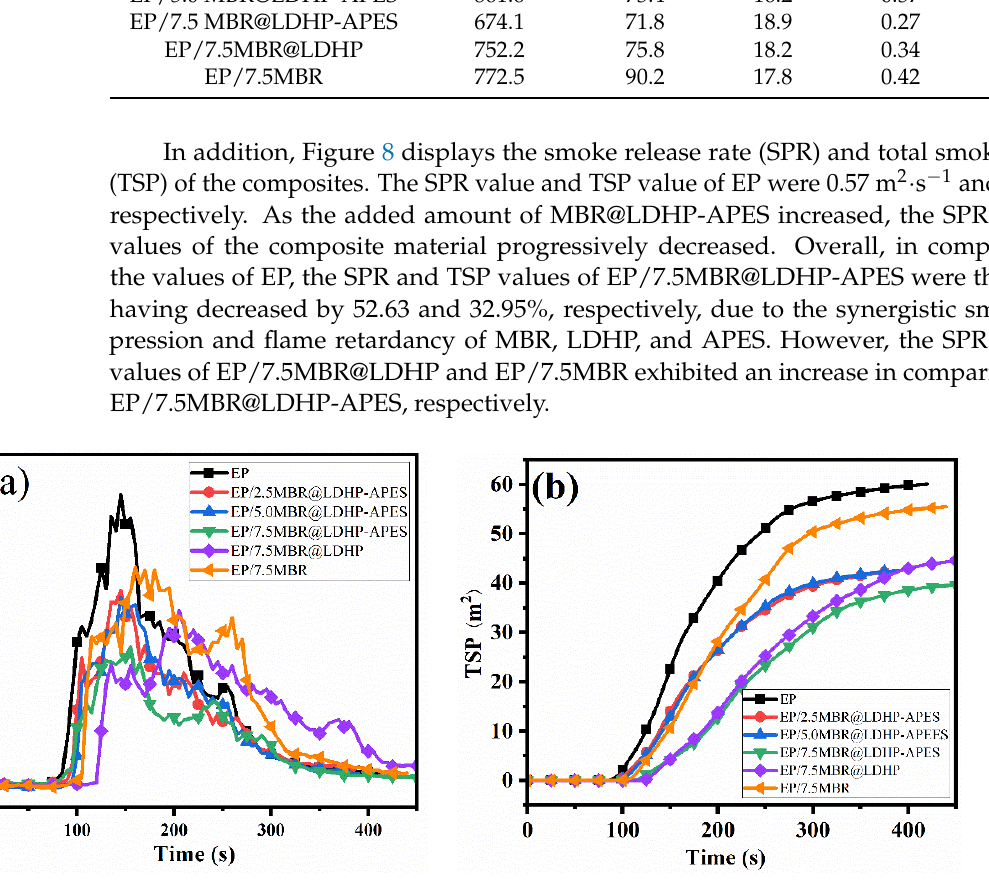
Figure 8. SPR ( a ) and TSP( b ) curves of pure EP and its composites. Table 4. CCT test results for EP and its composites.